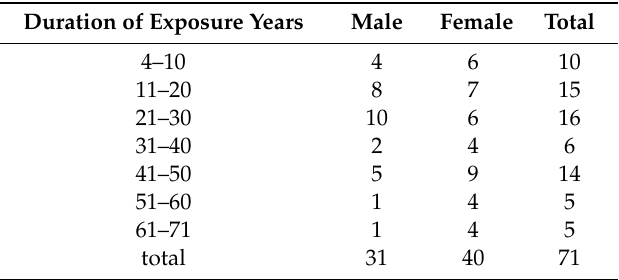
Table 6. The overall distribution by duration of exposure and sex is as follows.